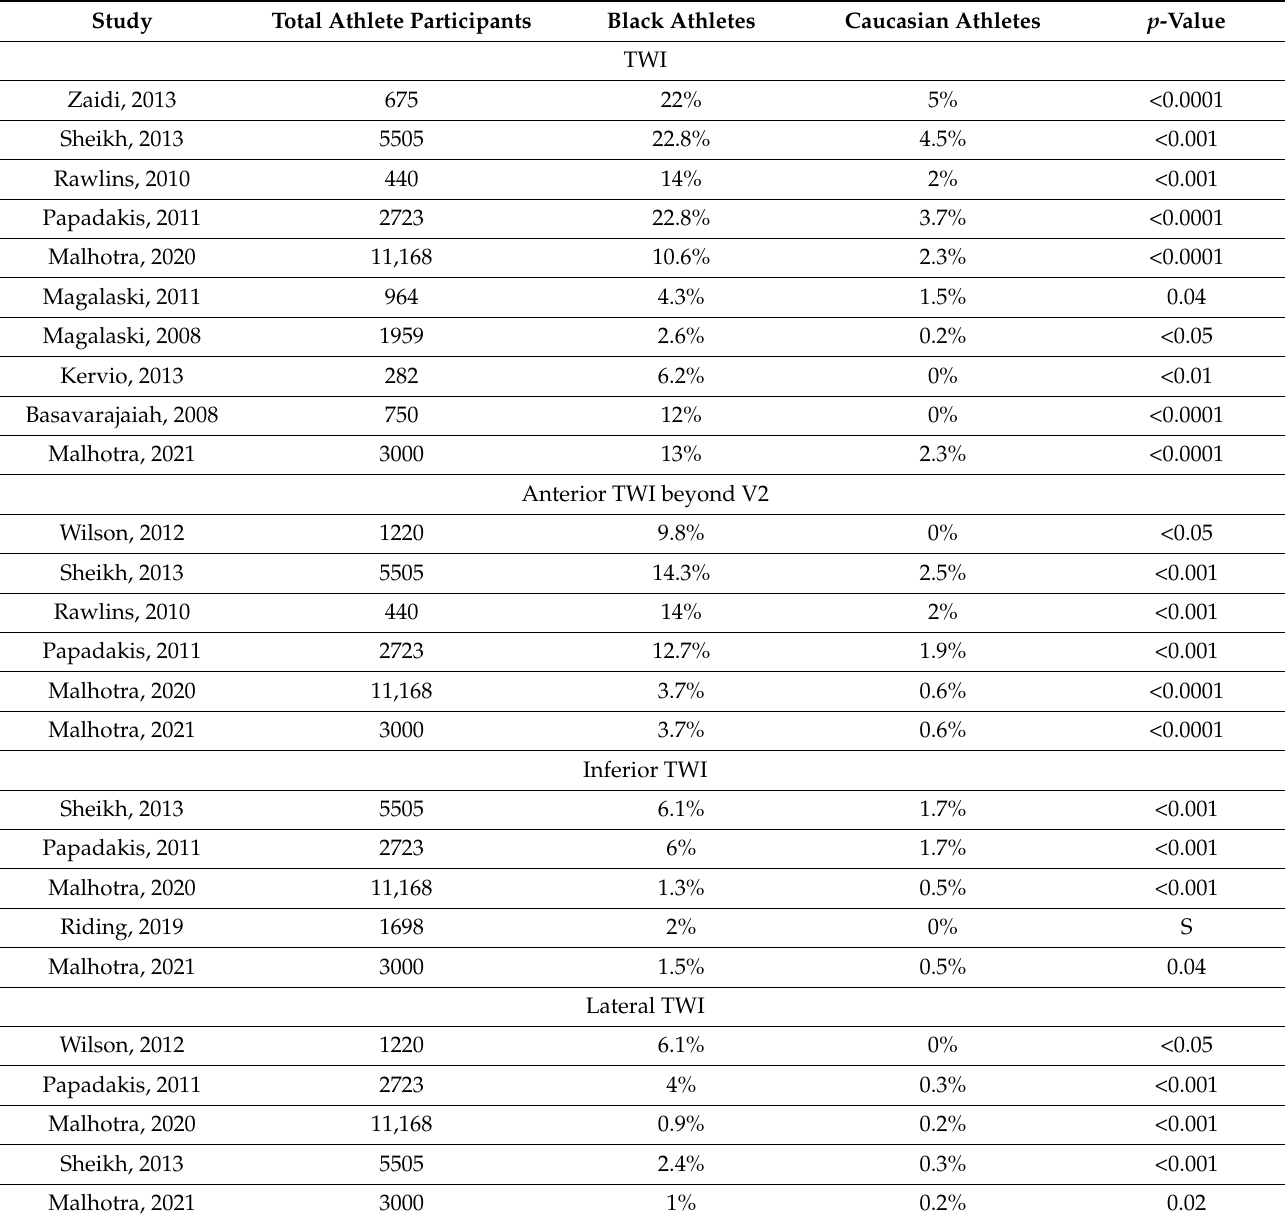
Table 1. Proportions of ECG changes in Black athletes compared to Caucasian